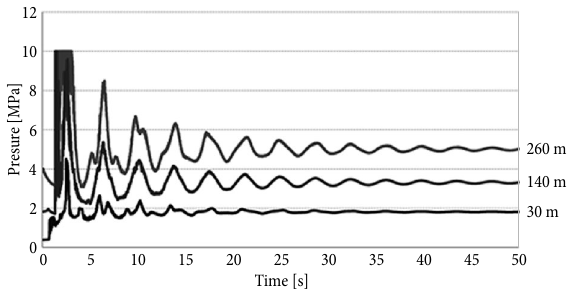
Fig. 7. Dependencies of pressure drop in the vertical pipe at different depths over time